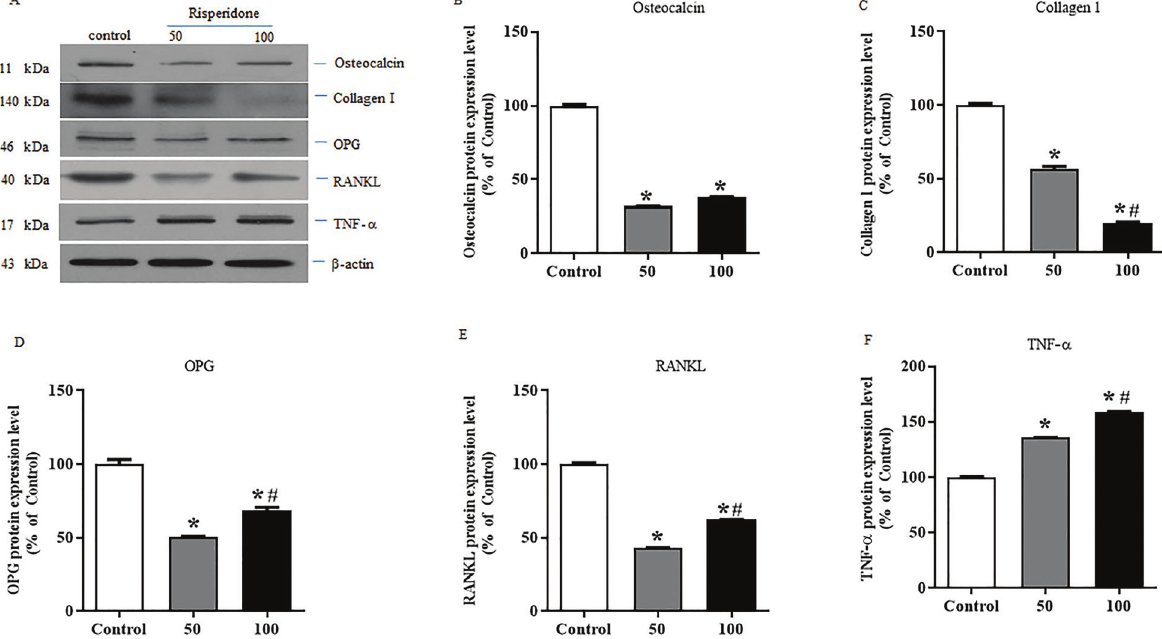
Figure 4. A , Osteoblast speci fi c protein expression detected by western blot. Osteocalcin, collagen 1, osteoprotegerin (OPG), receptor activator of nuclear factor kappa B ligand (RANKL), and tumor necrosis factor- a (TNF- a ) protein levels in MC3T3-E1 cells